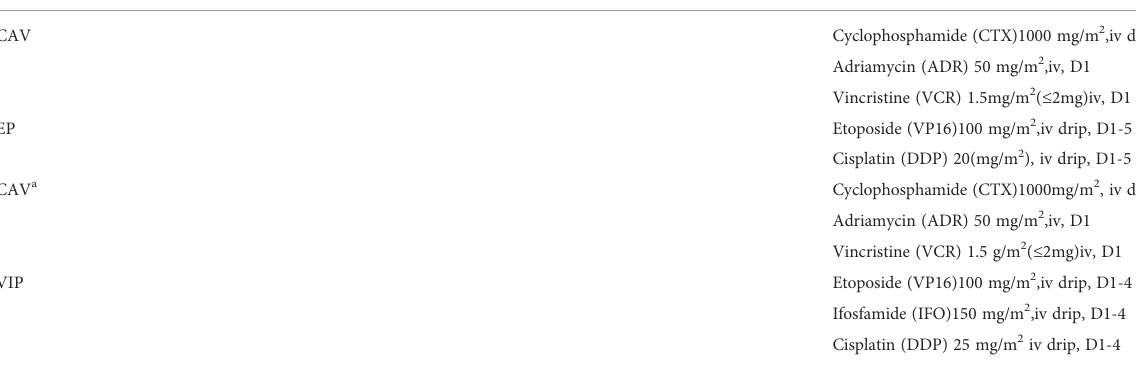
TABLE 1 Chemotherapy regimens for high-risk neuroblastoma.